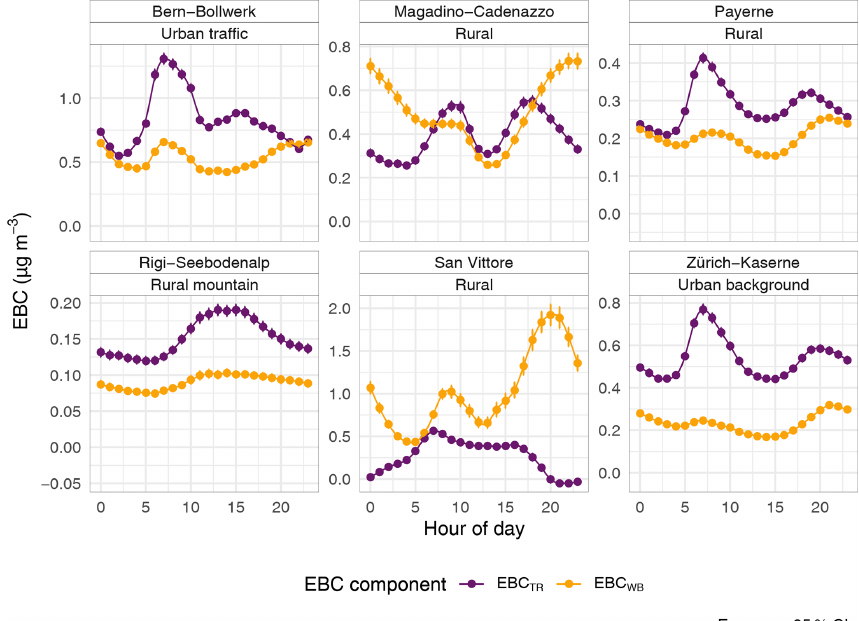
Figure 5. Mean hourly equivalent black carbon (EBC) components for the six monitoring sites. Note the different scales on the y axes. CI: confidence interval.